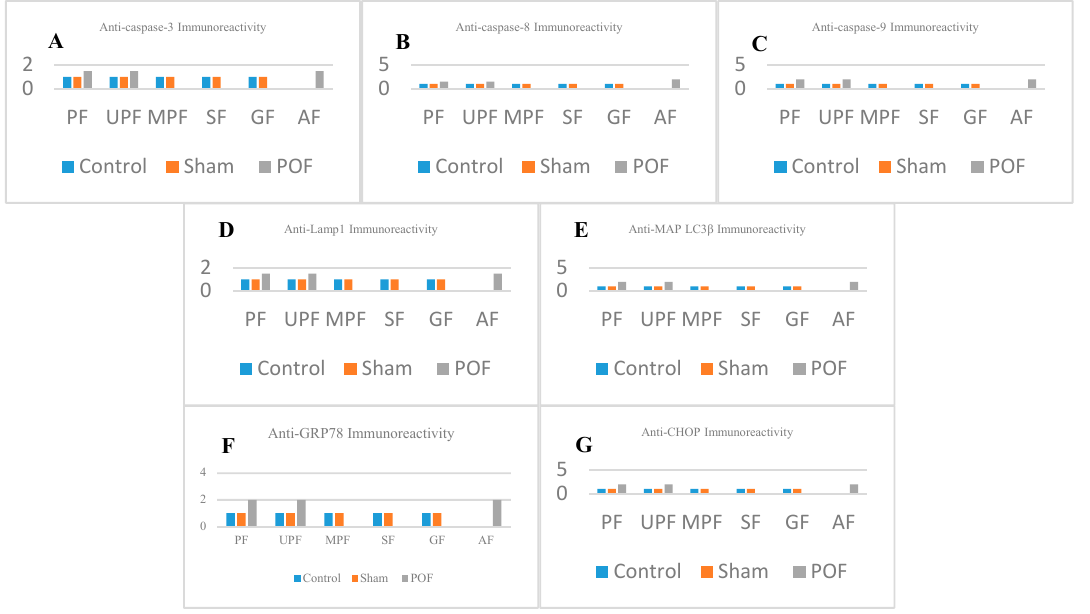
Figure 1. IHC analysis result of CDMs markers for apoptosis; ( A ) caspase 3, ( B ) caspase 8 and ( C ) caspase 9, for autophagy; ( D ) Lamp1, ( E ) MAP LC3 β and for paraptosis; ( F ) GRP78, ( G ) CHOP primer antiboies’s immunoreactivities. PF: Primordial Follicle, UPF: Unilaminar Primary Follicle, MPF:Multilaminar Primary Follicle, SF: Seconder Follicle, GF: Graaffian Follicle, AF: Atresic Follicle.